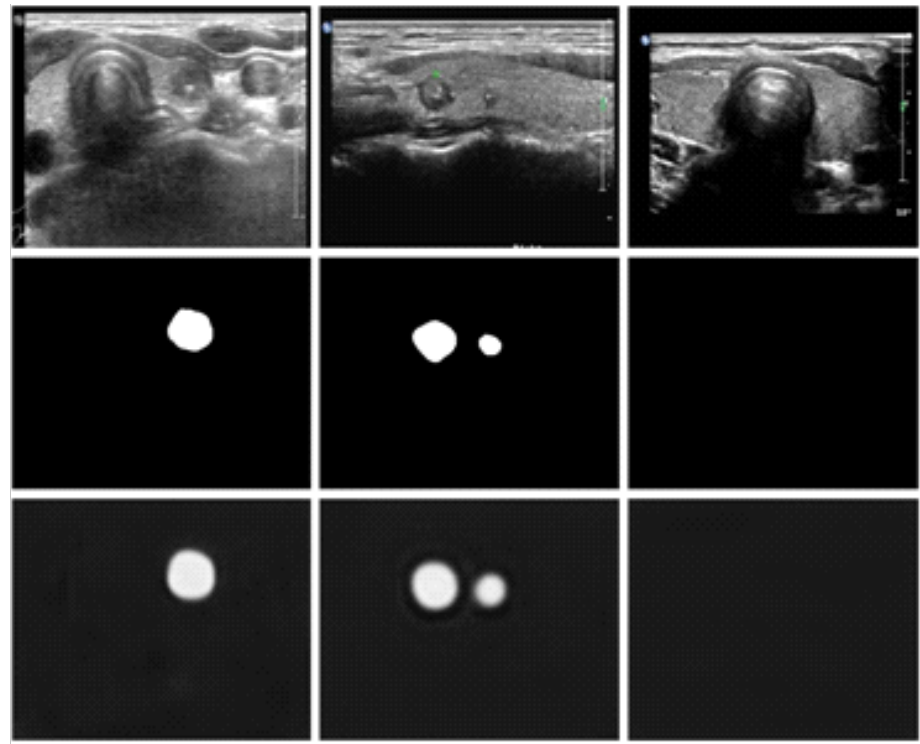
Figure 5 Segmentation probability maps of thyroid images generated by pre-trained convolutional neural network. Typical cases of thyroid nodule and normal thyroid images are shown in the first row; manually delineated ground truth masks and the segmentation probability maps generated by the PCNN are shown in the second and third rows,